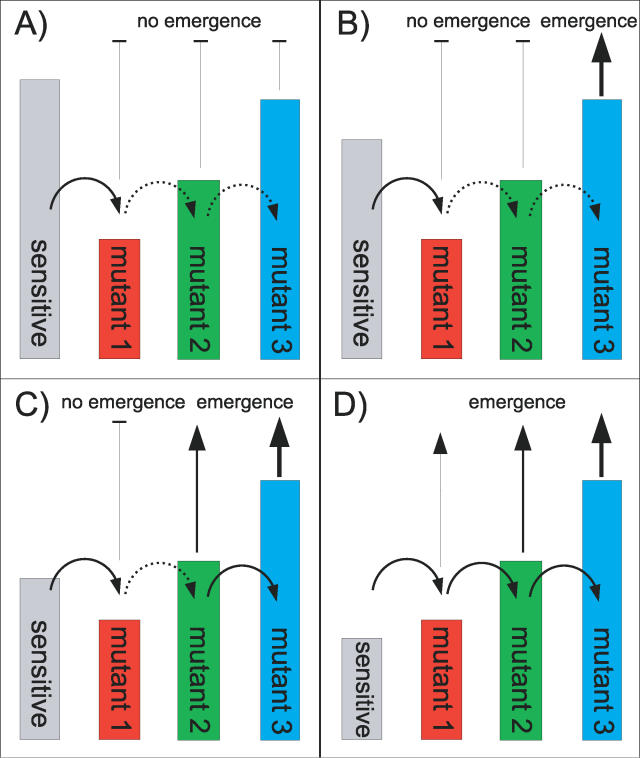
The Process of Resistance EmergenceThe bars indicate between-host fitness levels of the different strains. Solid curved arrows show conversion events that occur frequently due to large or expanding source populations.Dashed arrows show conversion events that occur infrequently due to small source populations.(A) Without treatment, all resistant strains are less fit than the sensitive strain. Therefore, resistance emergence is not possible.(B) Treatment of a small fraction of the population reduces fitness of the sensitive strain enough to allow for emergence of the fittest resistant strain. For that to happen, one frequent and two rare conversions need to occur.(C) Further increase in treatment level allows both the second and third resistant strains to emerge. For the second resistant strain to emerge, one frequent and one rare conversion need to occur. Subsequently, the third resistant strain is rapidly generated and will outcompete all other strains.(D) Treatment of a large fraction of the population results in all conversion events being frequent and in rapid emergence of resistance.